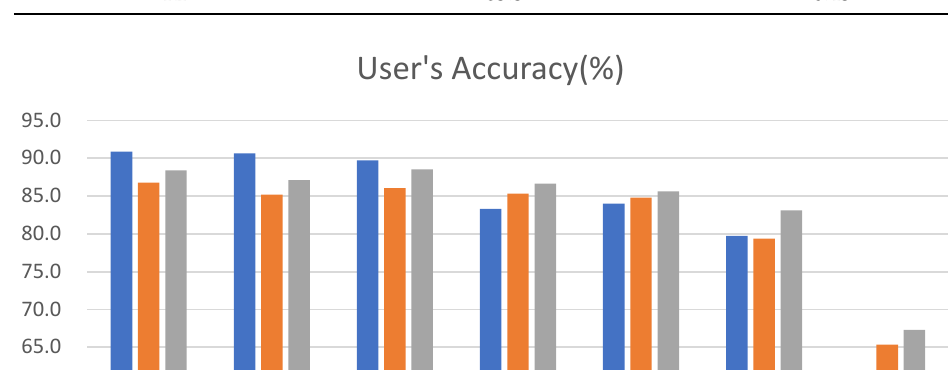
Figure 11. PA (producer’s accuracy) bar chart of seven algorithm calculated from confusion ma- trix.